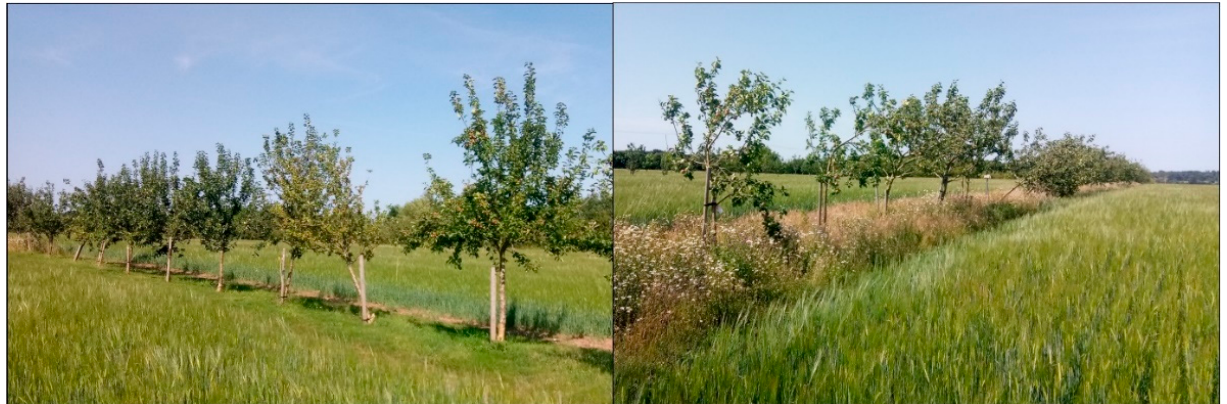
Figure 2. Photos of mown ( left ) and flowering ( right ) understoreys, taken in June 2020.